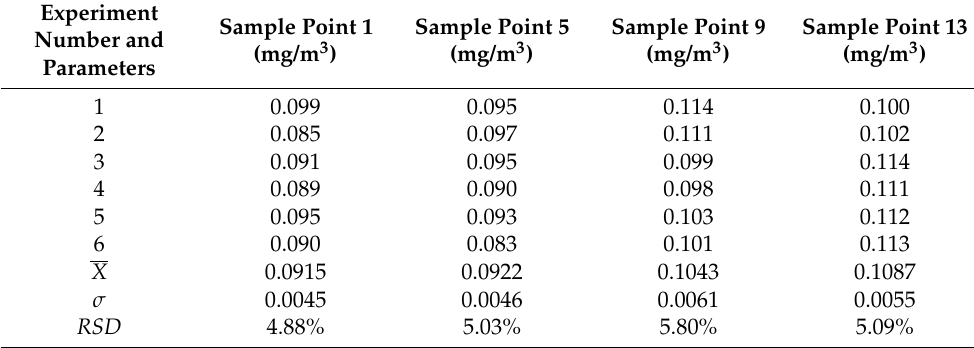
Table 4. Repeatability test results of dust concentration at four sampling